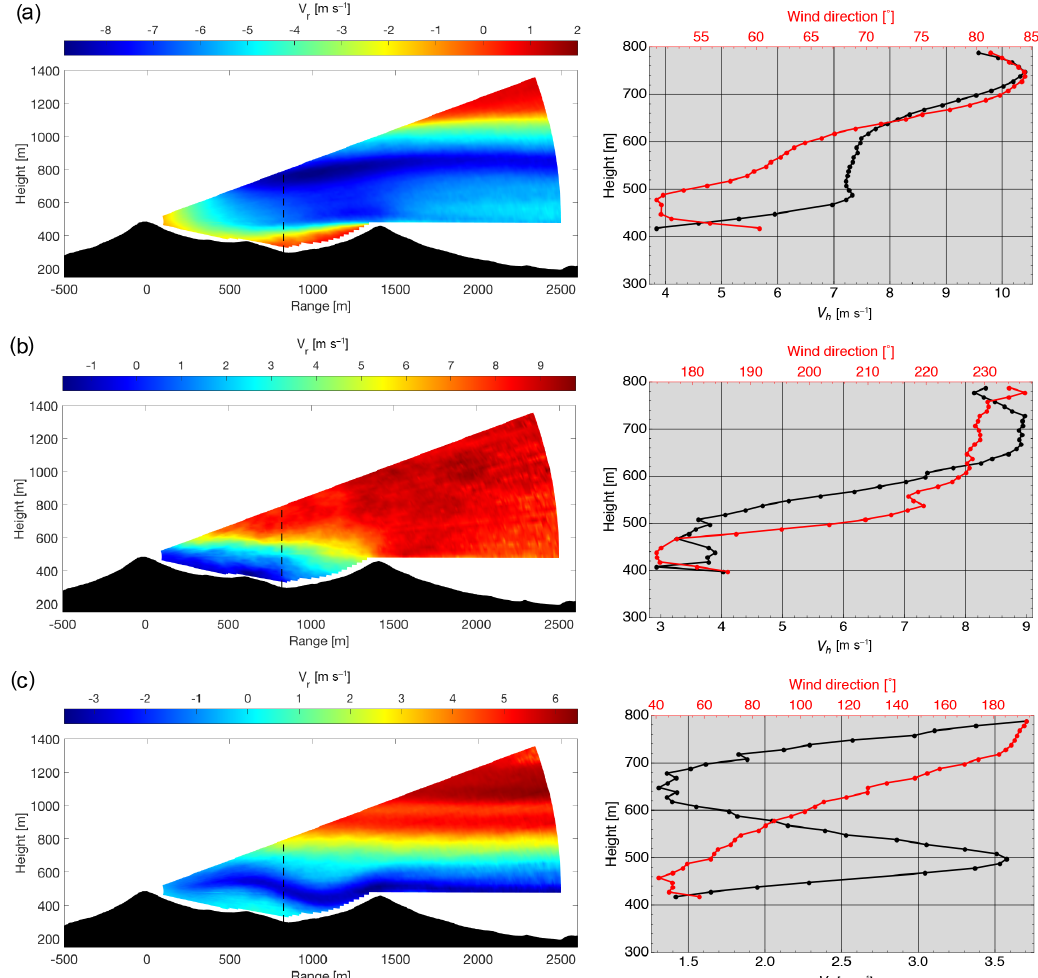
Figure 14. Radial flow fields (10min averaged) in a vertical plane (left figures) and corresponding virtual mast measurements of the horizontal wind speed and wind direction (right figures) acquired using the transect scan performed by the long-range WindScanner system: (a) northeast dominant wind, recirculation zone on the north ridge (measurements were taken on 7 June 2015 from 03:19 to 03:29UTC); (b) southwest dominant wind, recirculation zone on the south ridge (measurements were taken on 10 June 2015 from 13:33 to 13:43UTC); (c) northeast dominant wind, atmospheric internal wave (measurements taken on 10 June 2015 from 03:32 to 03:42UTC). Negative and positive radial wind speeds indicate winds going towards and away from the lidar, the black and red solid curves correspond to the horizontal wind speed and wind direction, and the dashed black line indicates a position of the virtual met mast. Note that the color pattern of the radial velocity field (left) is not the same in every